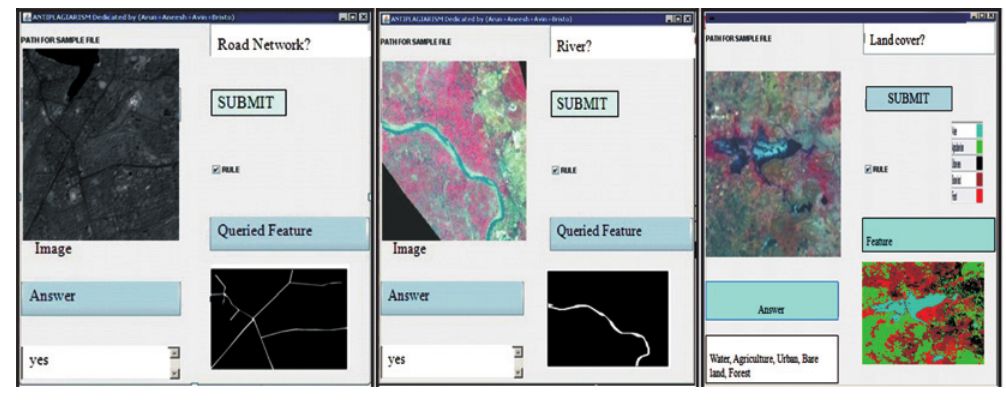
Fig. 2. Feature extraction